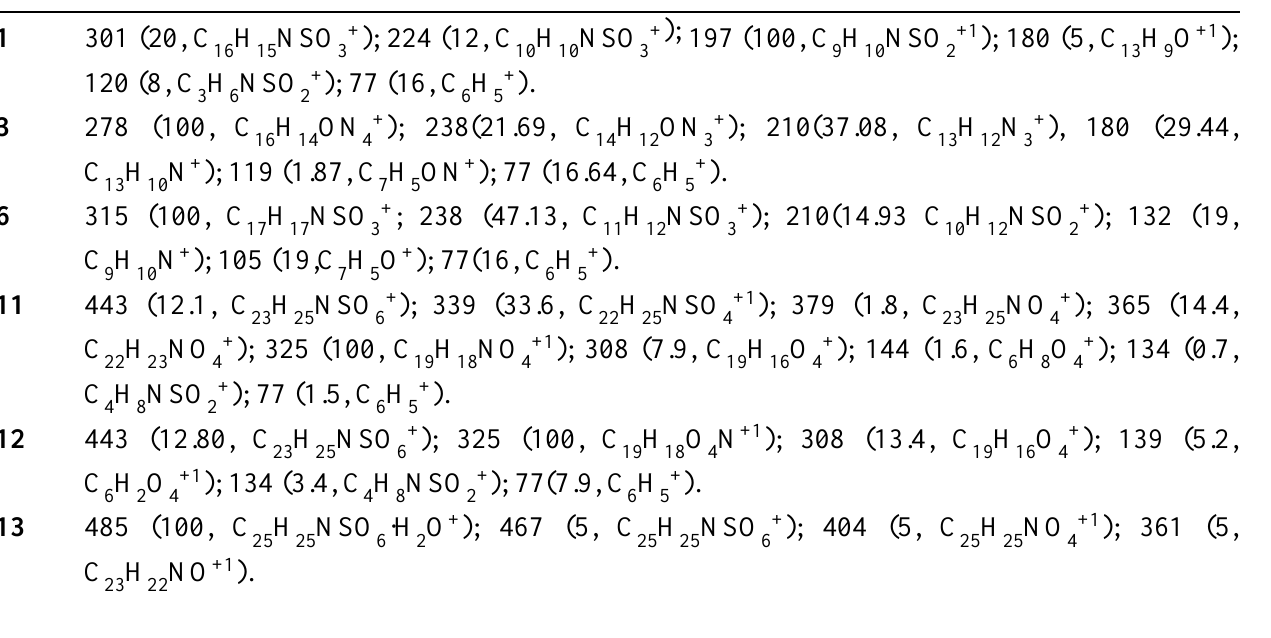
Table 1. Mass spectra of compounds 1 , 3 , 6 , 11 , 12 and 13